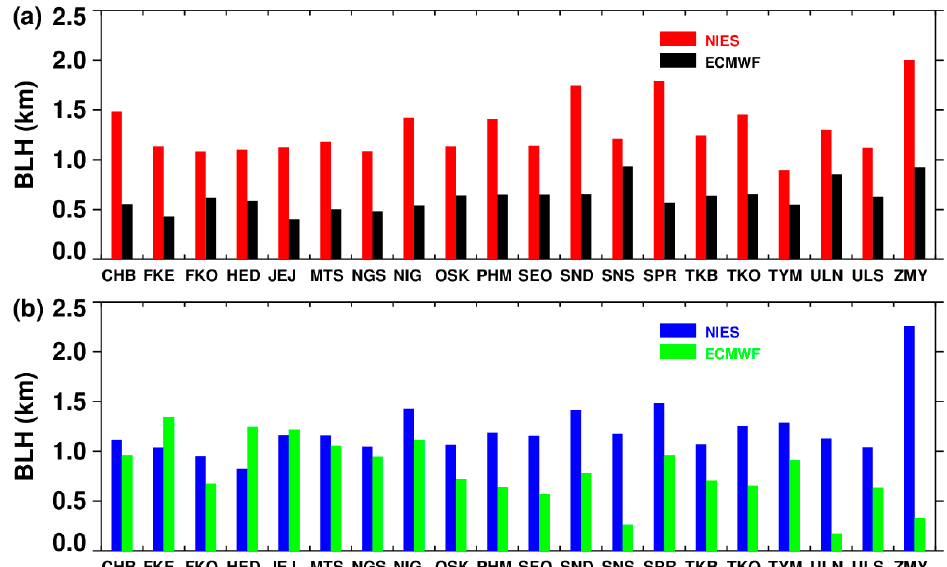
Figure 5. Comparison of the AD-Net PBL and ECMWFs PBL for 20 sites from AD-Net for summer ( a ) and winter ( b ).